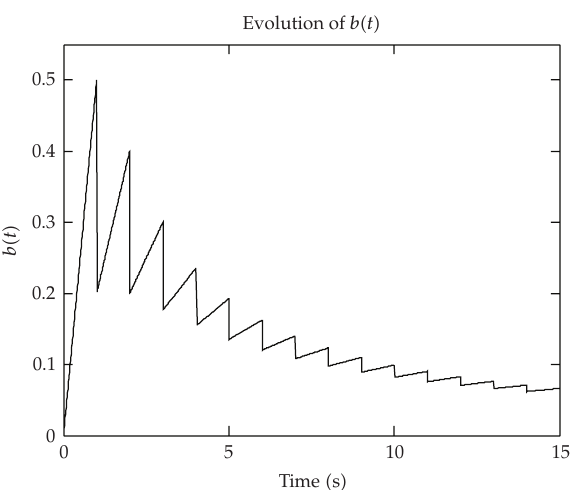
Figure 2: Graphical representation of b (cid:4) t (cid:5)